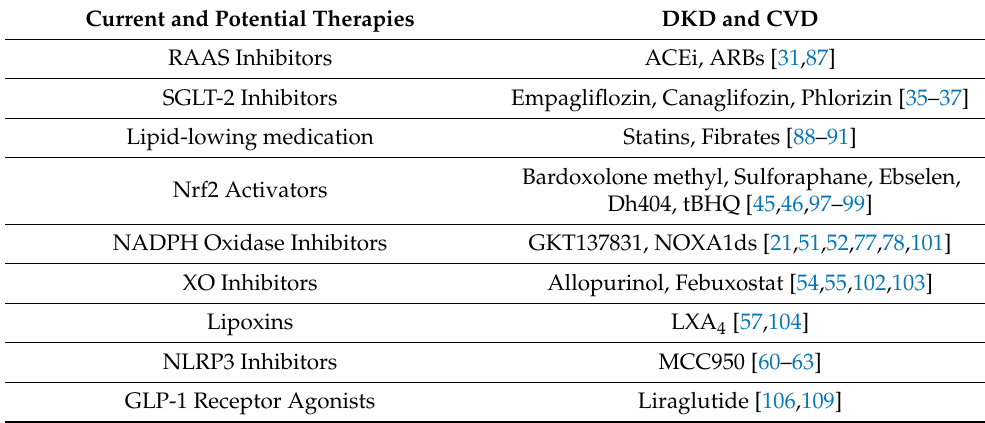
Table 1. Pharmacological approaches toward the renal and cardiovascular complications of